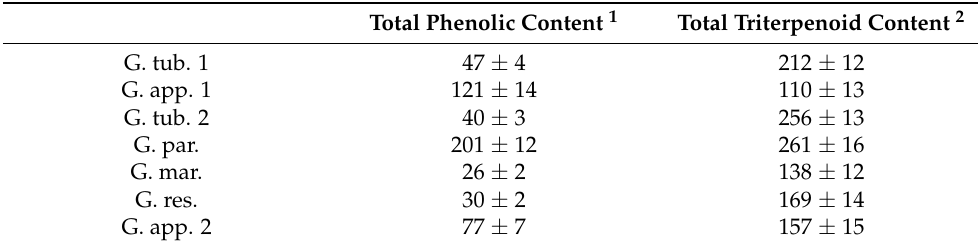
Table 2. Total phenolic and triterpenoid contents in the methanolic extracts of the 7 specimens